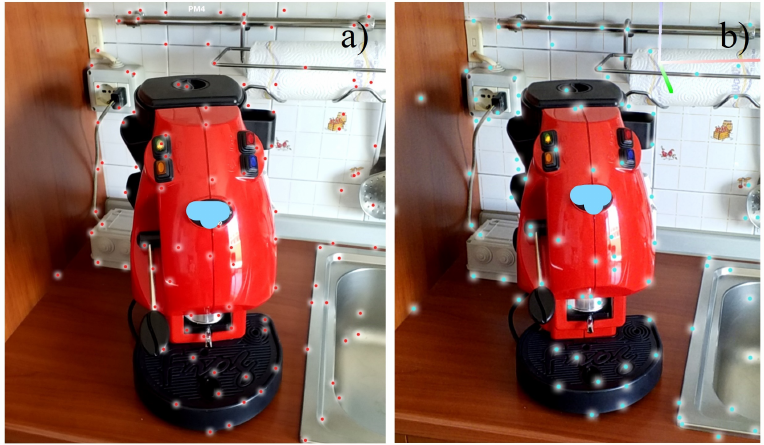
Figure 14. Features extraction process on an actual domestic appliance.